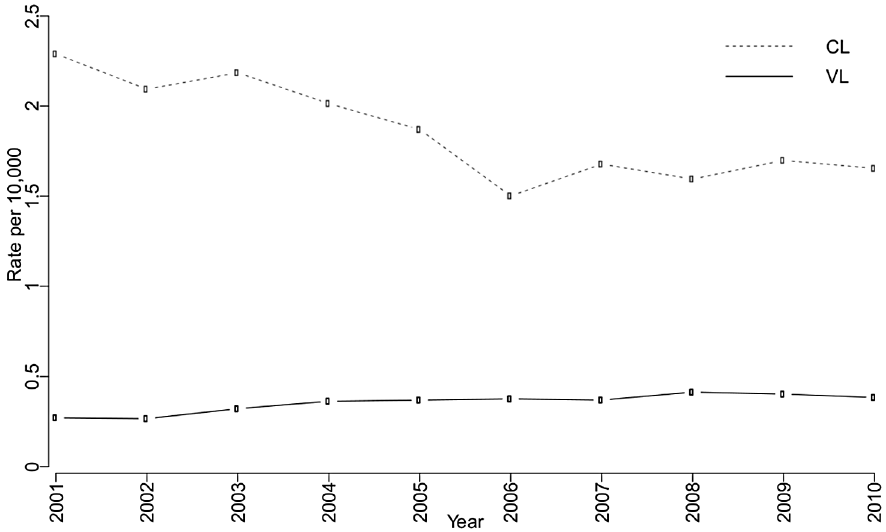
Figure 2. Temporal trend of observed countrywide incidence rates per 10,000. doi:10.1371/journal.pntd.0002213.g002 PLOS Neglected Tropical Diseases |